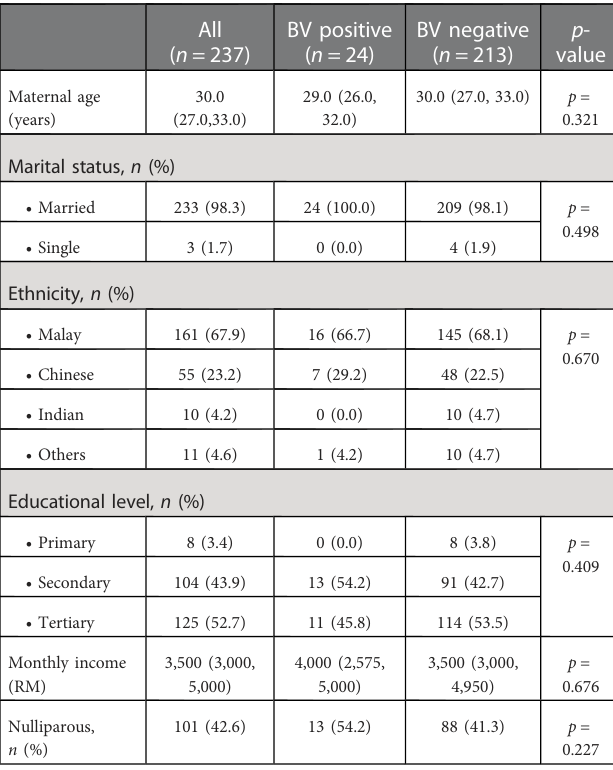
TABLE 1 Patient socio-demographic